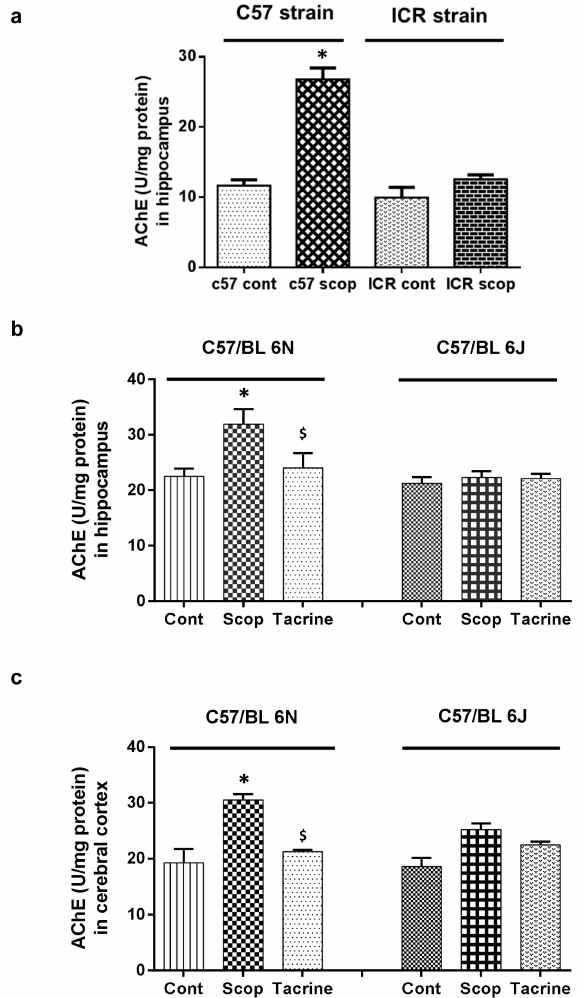
Figure 4. Acetylcholinesterase (AChE) activity in brain tissues of scopolamine-induced amnesic models: ( a ) Hippocampus of ICR and C57BL/6 strains; ( b ) Hippocampus and ( c ) cerebral cortex of C57BL/6N and C57BL/6J substrains. Data are expressed in U/mg protein as mean ± SD ( n = 4). One-way ANOVA-Tukey’s multiple comparison test was performed where, * p < 0.05 scopolamine compared with the control group; $ p < 0.05 tacrine compared with scopolamine-treated